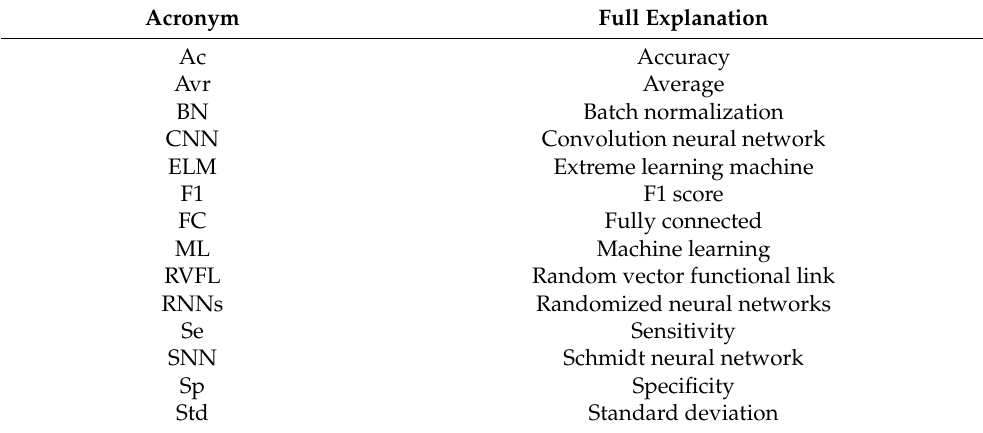
Table 1. Acronym and Full Explanation.